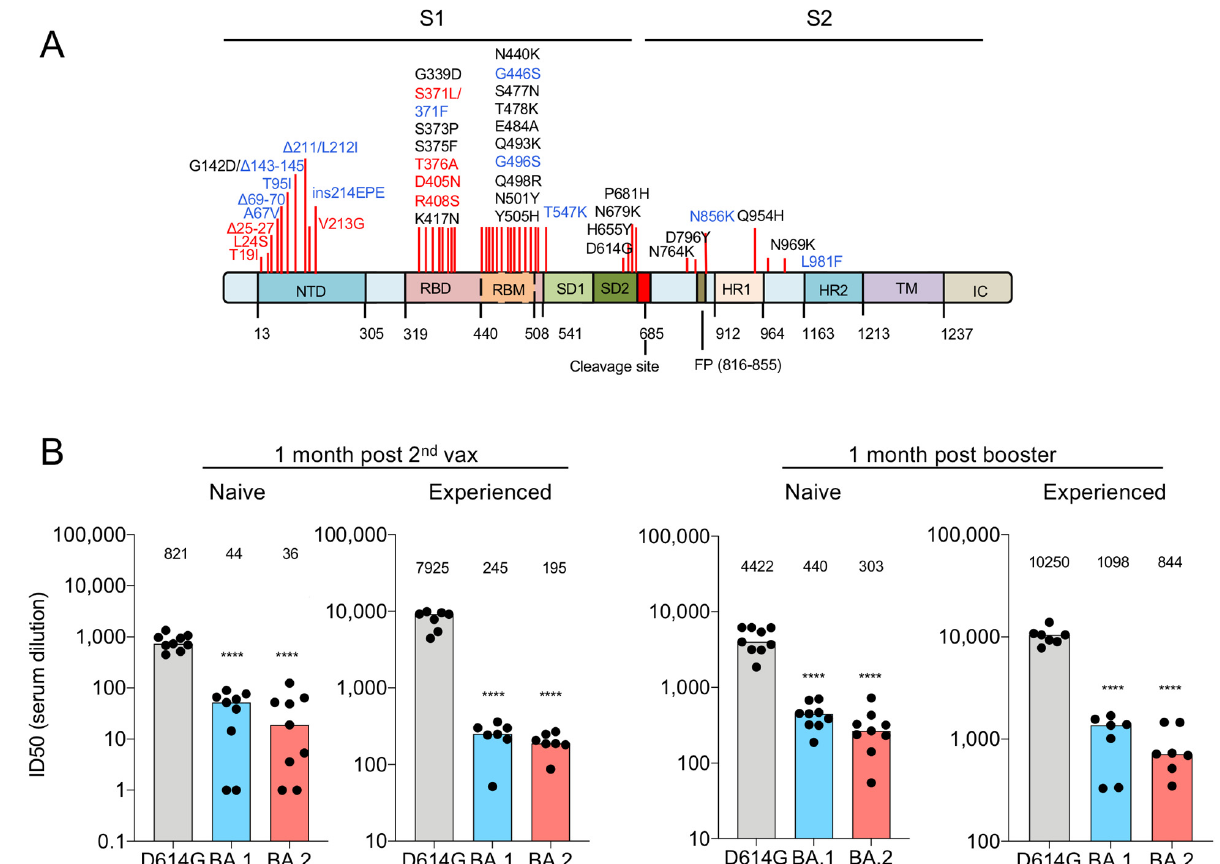
Figure 1. Decreased neutralization of Omicron BA.1 and BA.2 pseudotyped viruses by mRNA vaccine-elicited antibodies. ( A ) The structure of the SARS-CoV-2 Omicron BA.2 spike is indicated. NTD, N-terminal domain; RBD, receptor-binding domain; RBM, receptor-binding motif; SD1 subdomain 1; SD2, subdomain 2; FP, fusion peptide; HR1, heptad repeat 1; HR2, heptad repeat 2; TM, transmembrane region; IC, intracellular domain. Novel mutations found in BA.2 are shown in red. The mutations which are specific to BA.1 are shown in blue. ( B ) D614G, Omicron BA.1 and BA.2 pseudotyped viruses expressing dual GFP/nanoluciferase reporter genes with codon-optimized spike proteins were described previously [19]. Virus were incubated with a 2-fold serial dilution of serum for 30 min and applied to target cells. Luciferase activity was measured two days post-infection. Each serum dilution was measured in duplicates and the experiment was done twice with similar results. Statistical significance was calculated by two-sided testing. (**** p ≤ 0.0001). Neutralizing antibody titers of participants without ( n = 9) or with ( n = 7) SARS-CoV-2 infection were measured with pseudotyped viruses. Sera were collected from participants 1-month post-second vaccination with Pfizer BNT162b2 1-month post-boost. COVID-19 history was determined by symptoms and a PCR+ test or serology. The sera from SARS-CoV-2 experienced were collected prior to February 2021. Thus, the individuals would have been infected with D614G, Alpha or Iota variant.